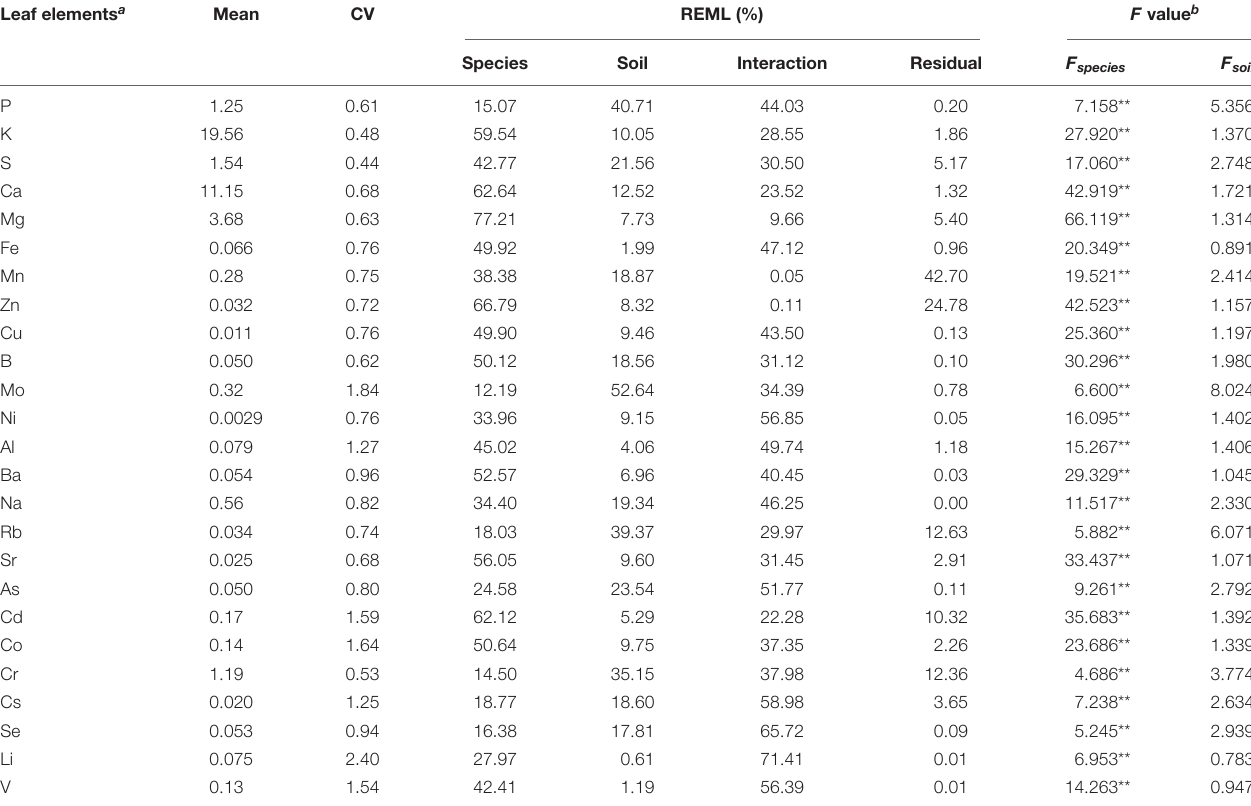
TABLE 1 | Variations in leaf elemental concentrations among plant species and soil conditions ( n = 549). Leaf elements